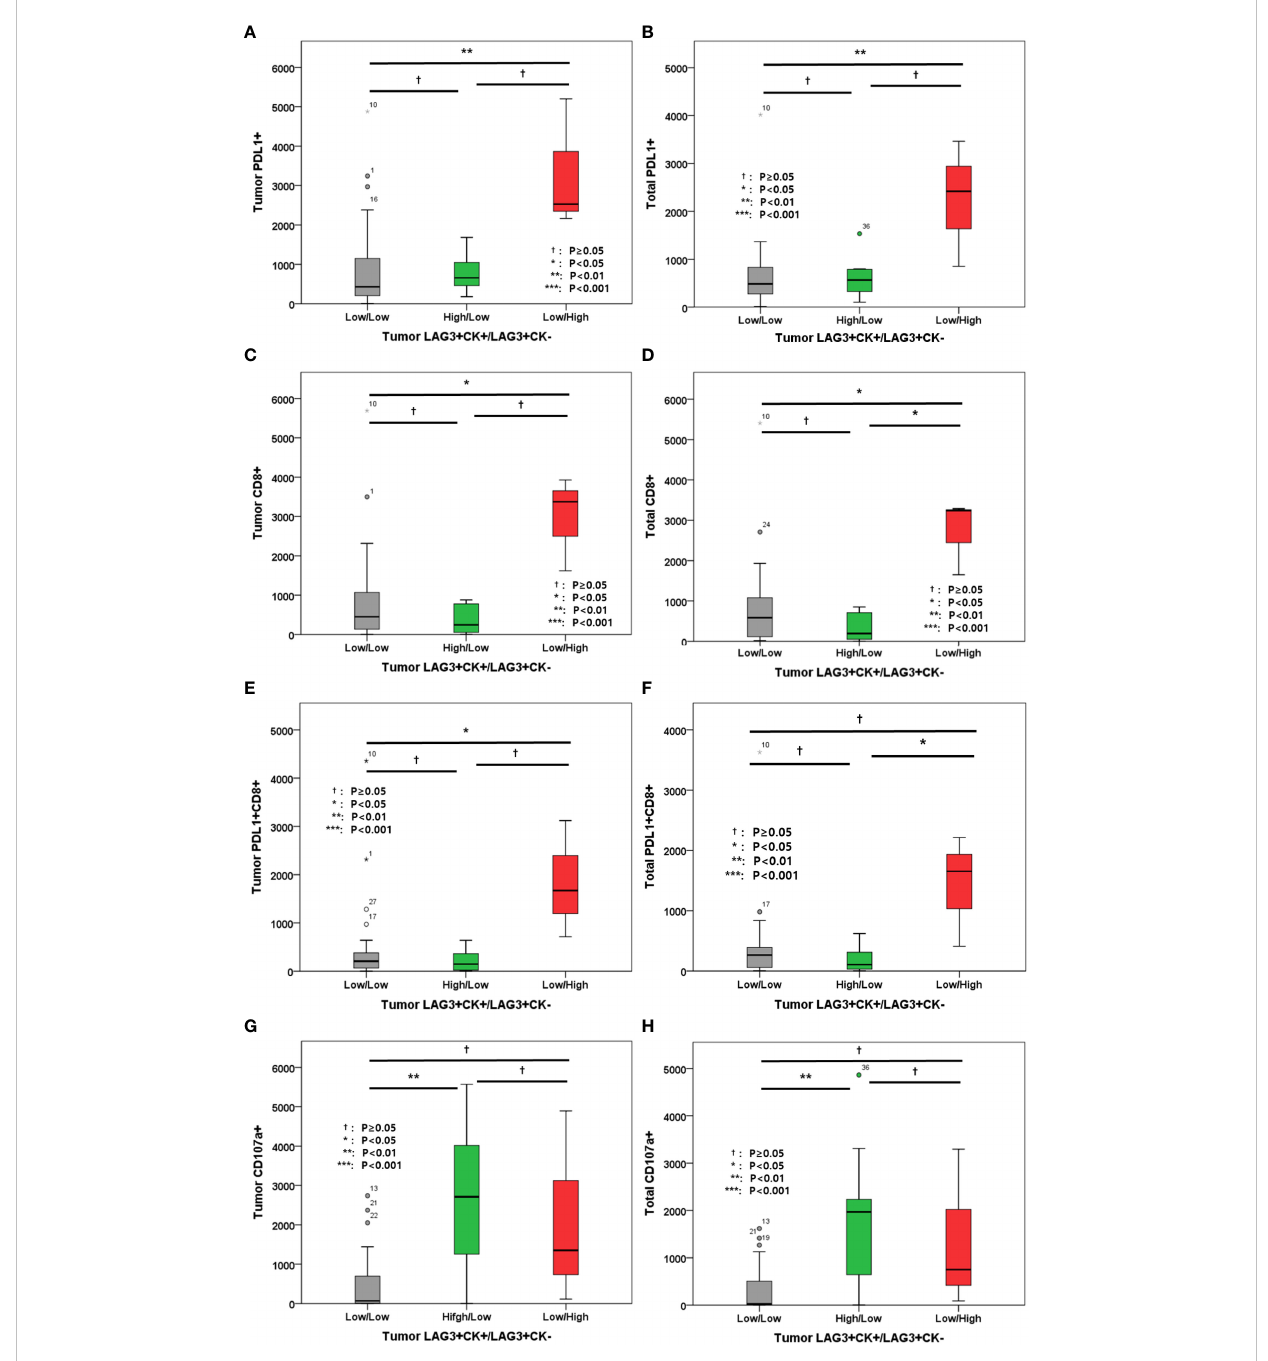
FIGURE 6 (A) Level of tumor PD-L1+ cells; (B) Level of total PD-L1+ cells; (C) Level of tumor CD8+ cells; (D) Level of total CD8+ cells; (E) Level of tumor PD- L1+CD8+ cells; (F) Level of total PD-L1+CD8+ cells; (G) Level of tumor CD107a+ cells; (H) Level of total CD107a+ cells according to tumor LAG-3 +CK+/LAG-3+CK-